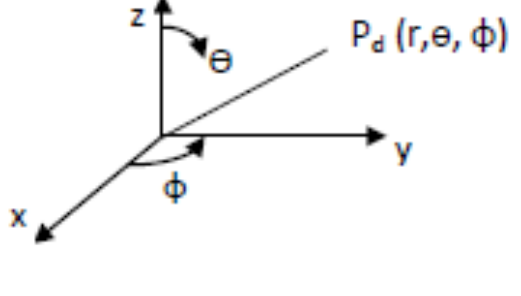
Figure 5. Radiation Pattern